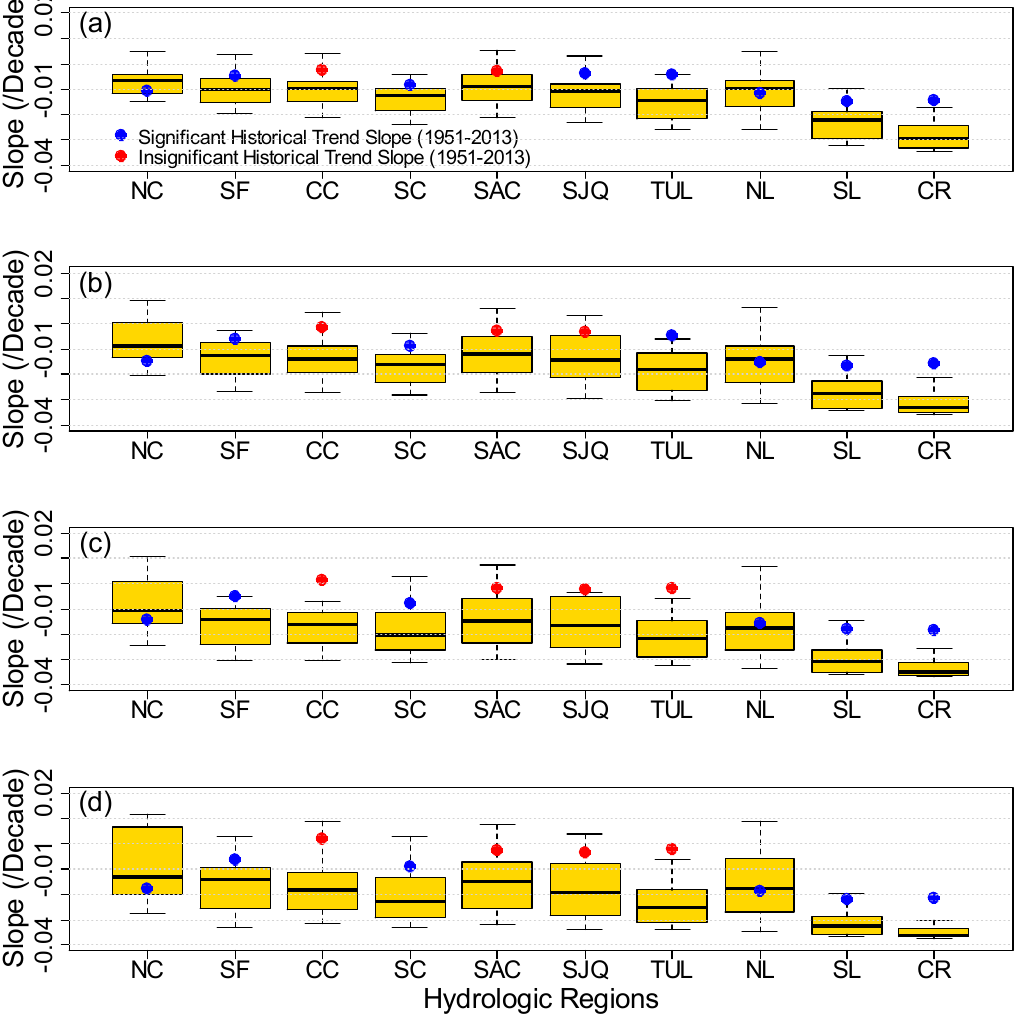
Figure 11. Box-and-whisker plots of significant trend slopes of: ( a ) SPEI-12; ( b ) SPEI-24; ( c ) SPEI-36; and ( d ) SPEI-48 during projection period (2020–2099) (at significance level 0.05). The slope information in historical period (1951–2013) is also shown.